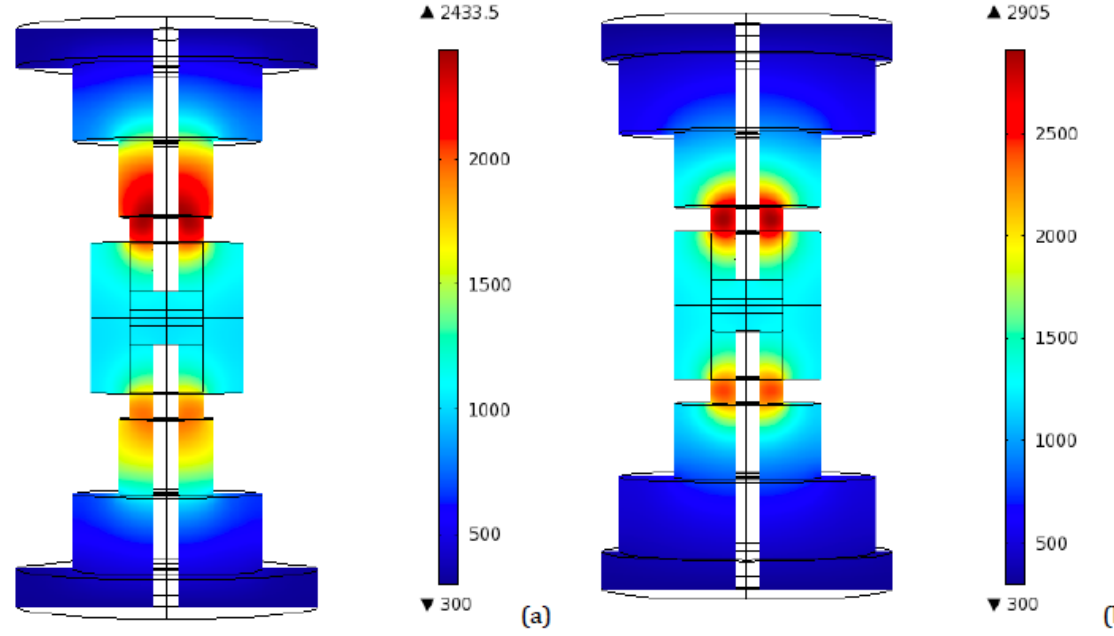
Figure 7. Peak temperature distribution (K)—Resistive contact—two transitional disks configuration. ( a ) Radii: 50 and 25 mm—Heights: 40 mm each; ( b ) Radii: 70 and 40 mm—Heights: 40 mm each.